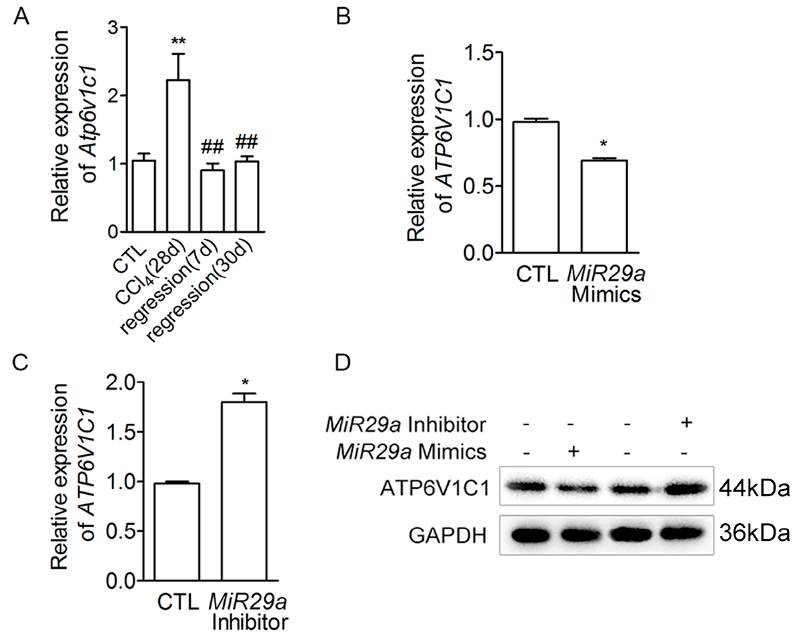
Figure 3. The expression of ATP6V1C1 in cells and CCl 4 -induced mice. ( A ) Mice and littermate control mice were treated with oil or CCl 4 for 28 days, and liver tissues were harvested for the following analyses at the indicated time points. qRT-PCR analysis of Atp6v1c1 mRNA expression ( n = 5 per group). Error bar represents SEM. ** p < 0.01 vs. CTL group. ## p < 0.01 vs. CCl4 (28d) group. ( B , C ) MIR29a mimics (100 nM) or MIR29a inhibitor (200 nM) were transiently transfected into LX-2 cells for 24 h, and the cells were treated with RSG (5 µ M) for 24 h. The expression of ATP6V1C1 mRNA was assessed by qRT-PCR ( n = 3 per group). Error bar represents SEM. * p < 0.05. ( D ) Protein expression levels of ATP6V1C1 in cell extracts were assessed by Western blot. GAPDH was used as a loading control.